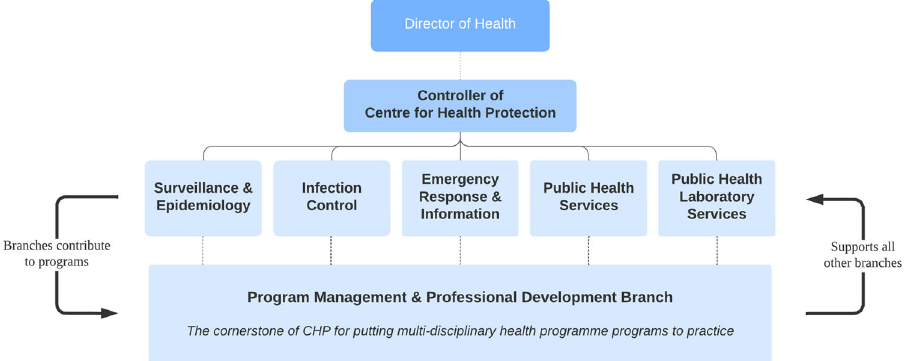
Fig. 3 The six branches of CHP. Each of CHP ’ s six branches provide different services, yet they collaboratively and collectively serve the wider purpose of public health